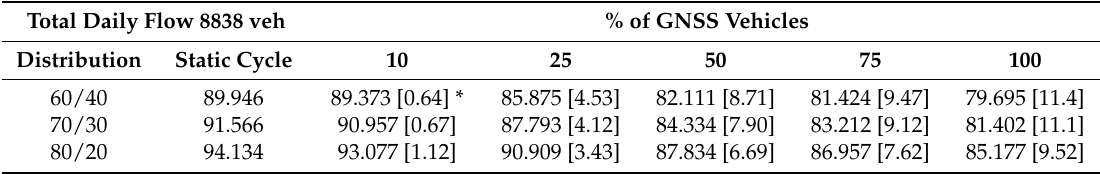
Table 7. Average CO 2 pollution [g/km], in a typical day, for Case A.